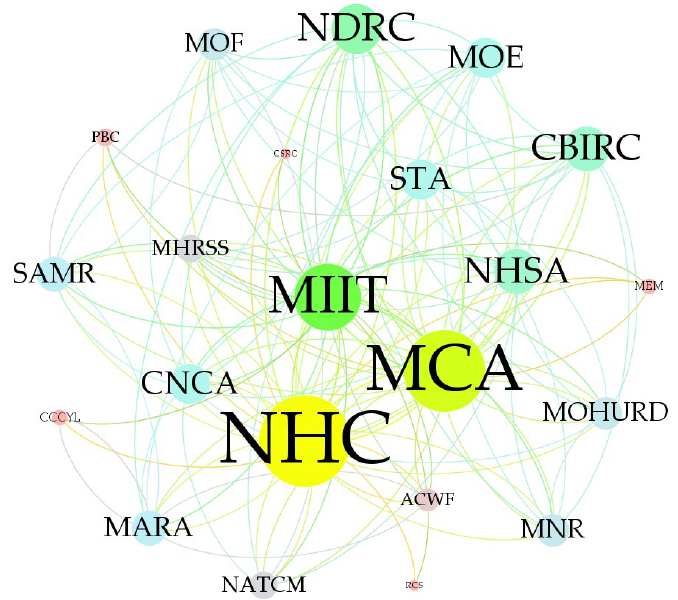
Figure 3. The global visualization result of the HnICN.